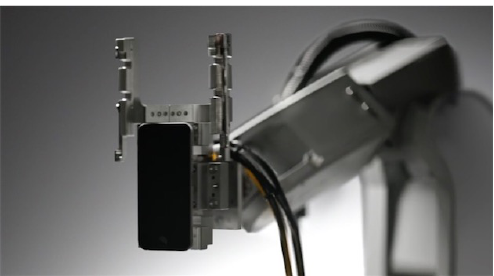
Figure 5. Liam, a collaborative robot by Apple which disassembles